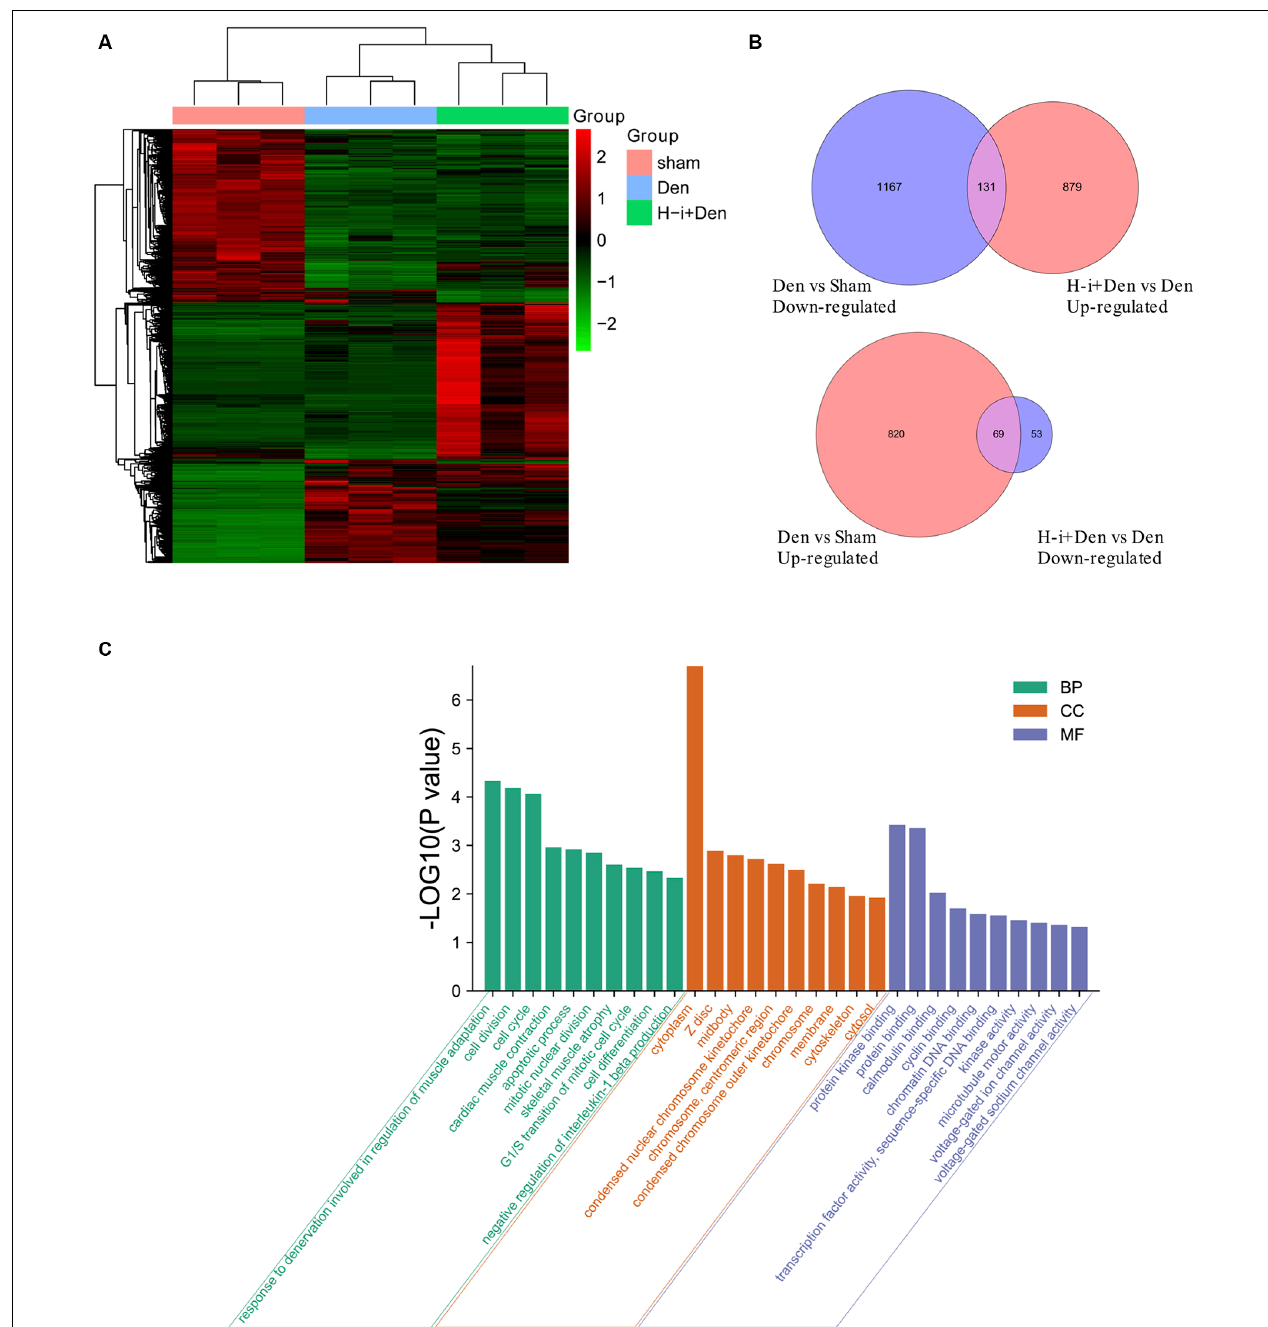
FIGURE 3 | Effects of HDAC4 inhibition on the transcriptome of atrophied muscles induced by denervation. (A) Heat map of gene expression of tibialis anterior muscle in H-i+Den group (H-i+Den), den group (Den) and sham group (Sham) at 7 days after the operation. Clustering of all the differentially expressed genes ( P < 0.001; A Fold change 2 or higher). The standardized expression level, from green to red, represents expression level from low to high, n = 3. (B) Venn diagrams of down-regulated genes after denervation and up-regulated genes after interference with HDAC4; Venn diagram of up-regulated genes after denervation and down-regulated genes after interference with HDAC4. (C) GO (Gene ontology) analysis was performed on further screened differentially expressed genes.